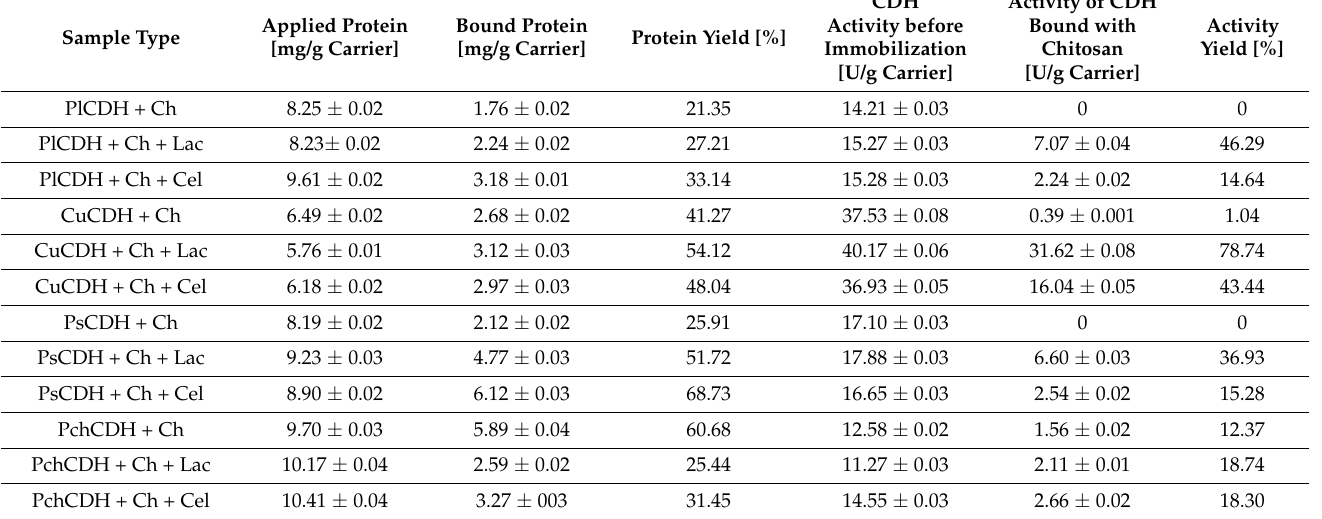
Table 1. Efficiency of cellobiose dehydrogenase adsorption on the chitosan support (Ch) containing CDHs isolated from P. lindtneri : Pl CDH + Ch, with lactose Pl CDH + Ch + Lac, with cellobiose Pl CDH + Ch + Cel, from C. unicolor : Cu CDH + Ch, Cu CDH + Ch + Lac, Cu CDH + Ch + Cel, from P. sanguineus